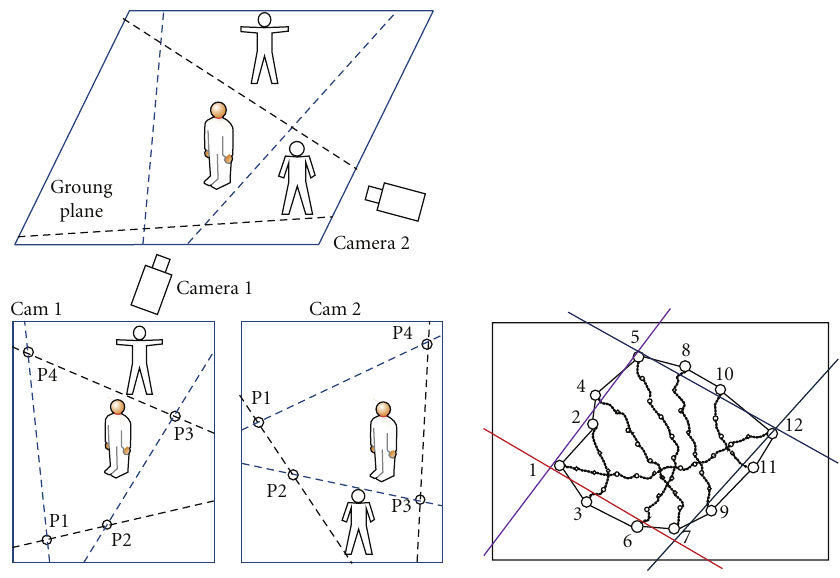
Figure 1: Detecting the overlapping zones based on FoV lines (left), and gathered person trajectories in o ff -line phase (right).